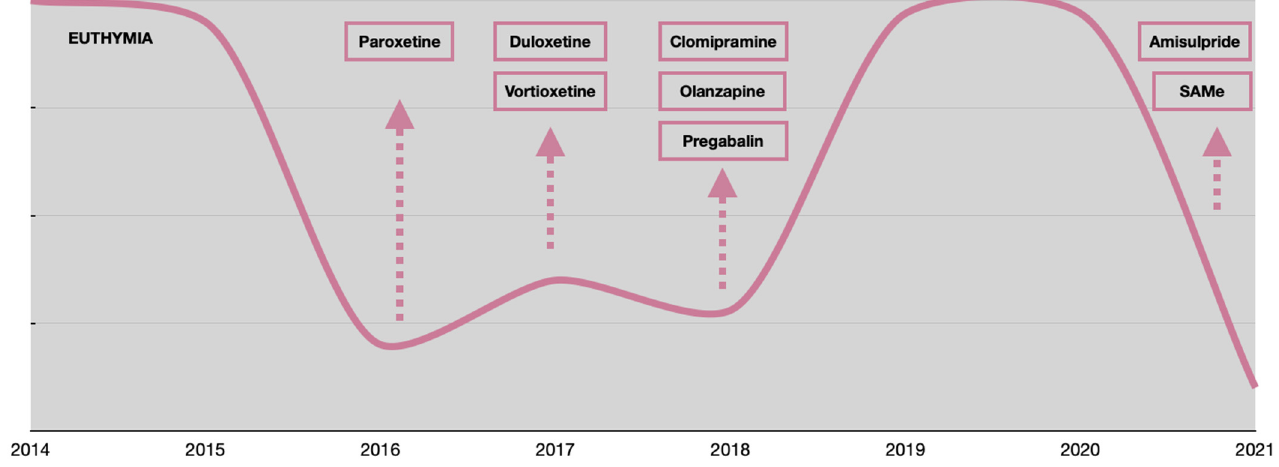
Figure 1. Mood variations from 2014 to 2021.